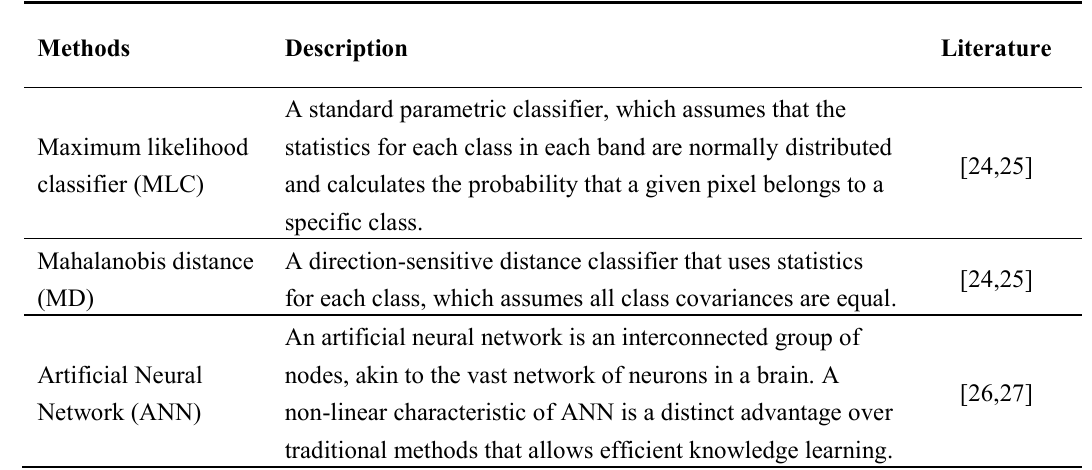
Table 4. Characteristics of algorithms used in this study for disease